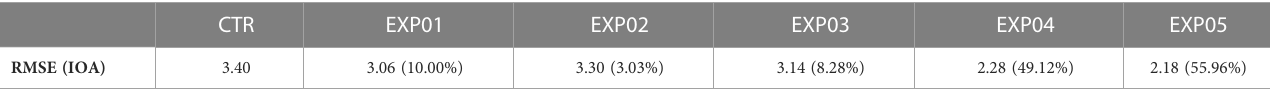
The number in the parentheses below RMSE represents IOA. RMSE, root-mean-square error; IOA, impact of assimilation. CTR, control; EXP, experiment.